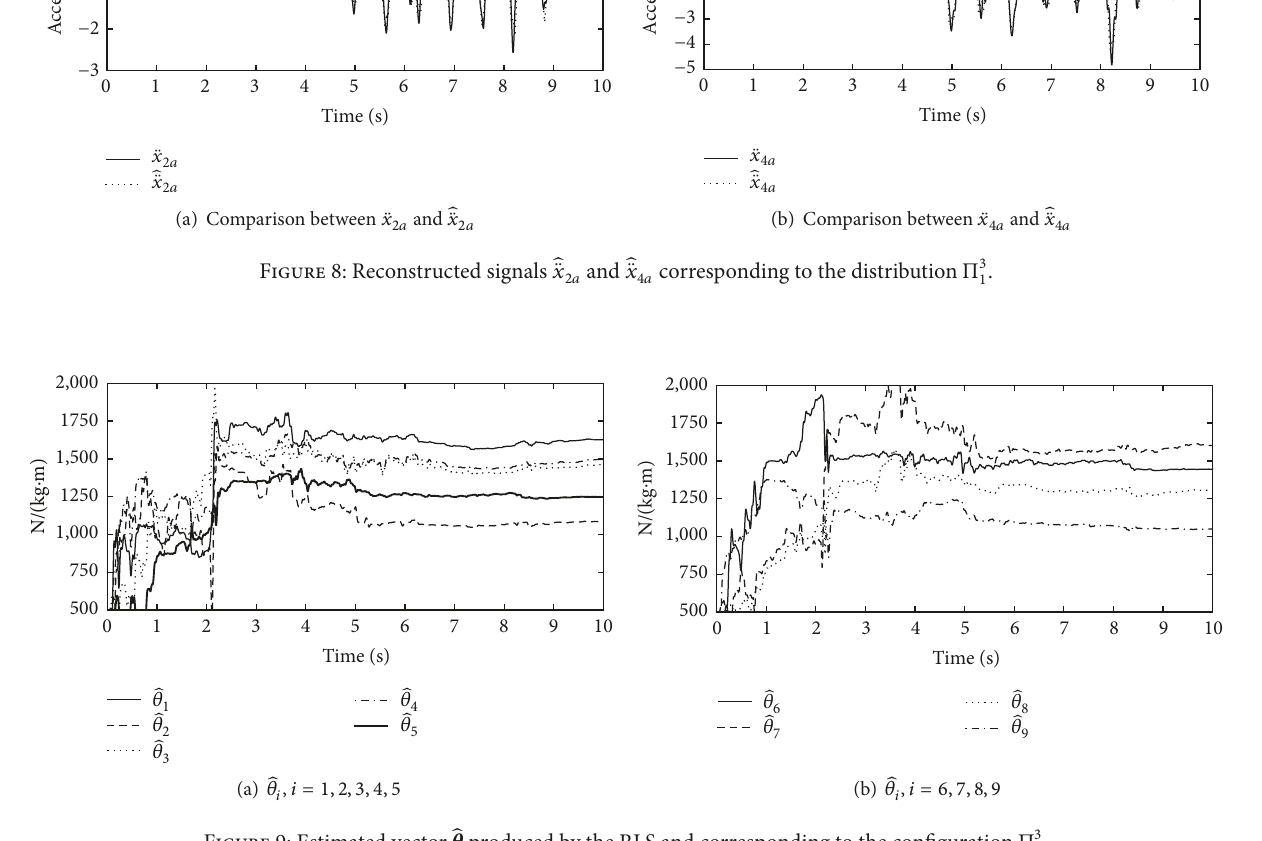
̂ 𝜃 Figure 9: Estimated vector produced by the RLS and corresponding to the configuration Π 3 1 .